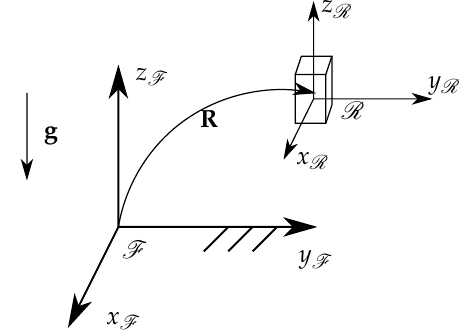
Figure 2. Geometric representation of the